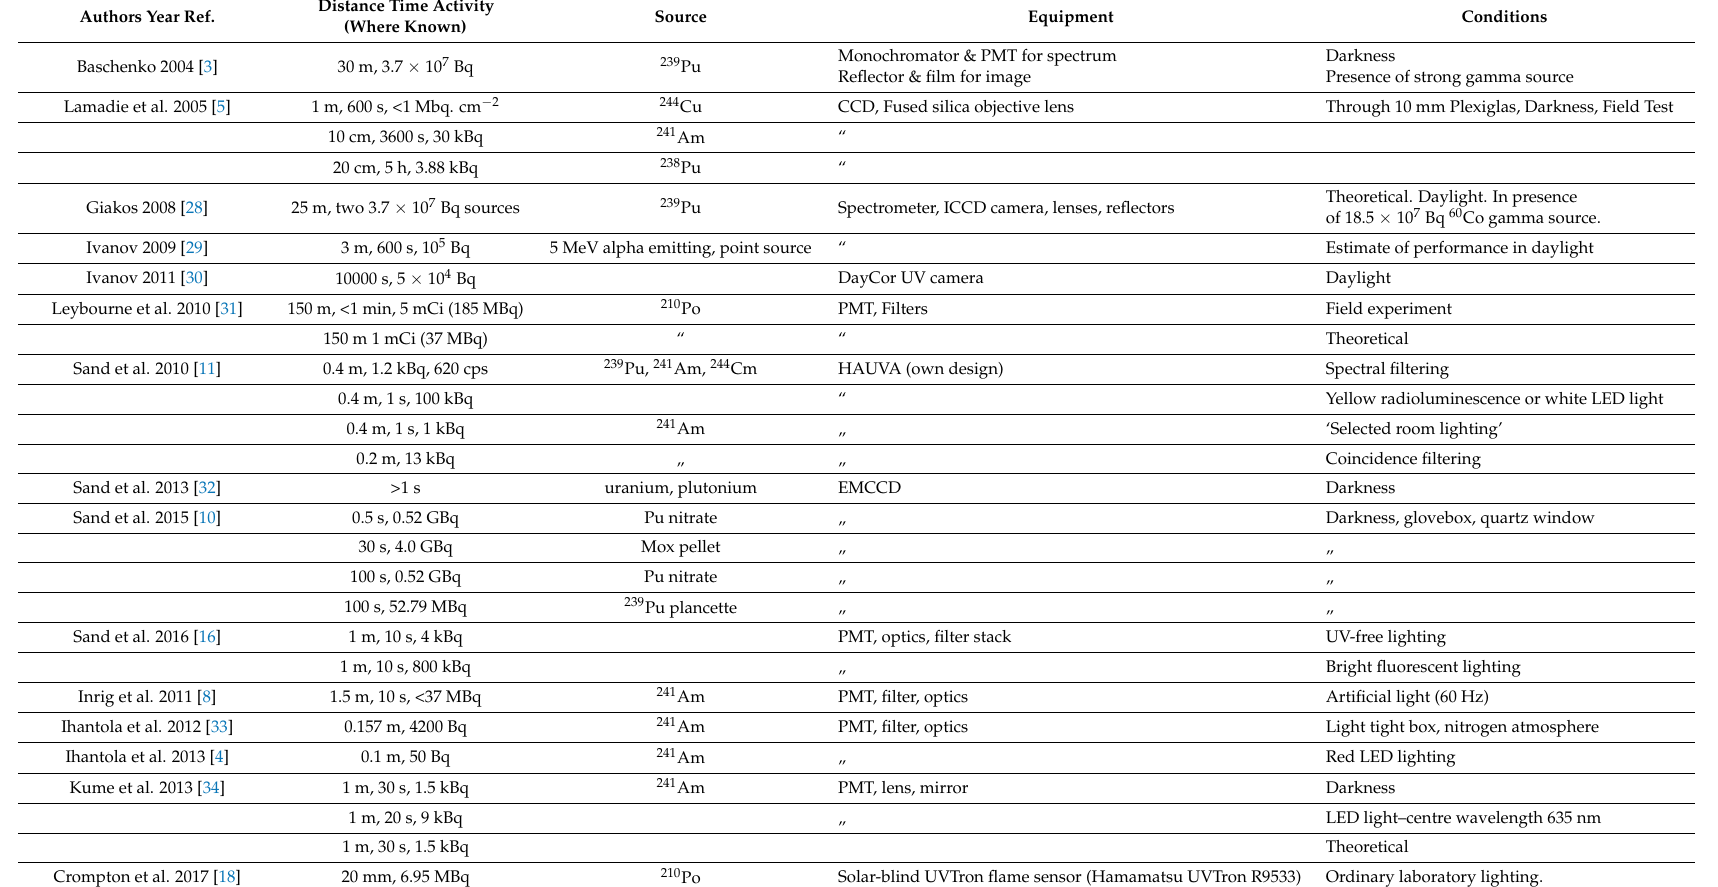
Table 1. Summary of alpha particle detection research to